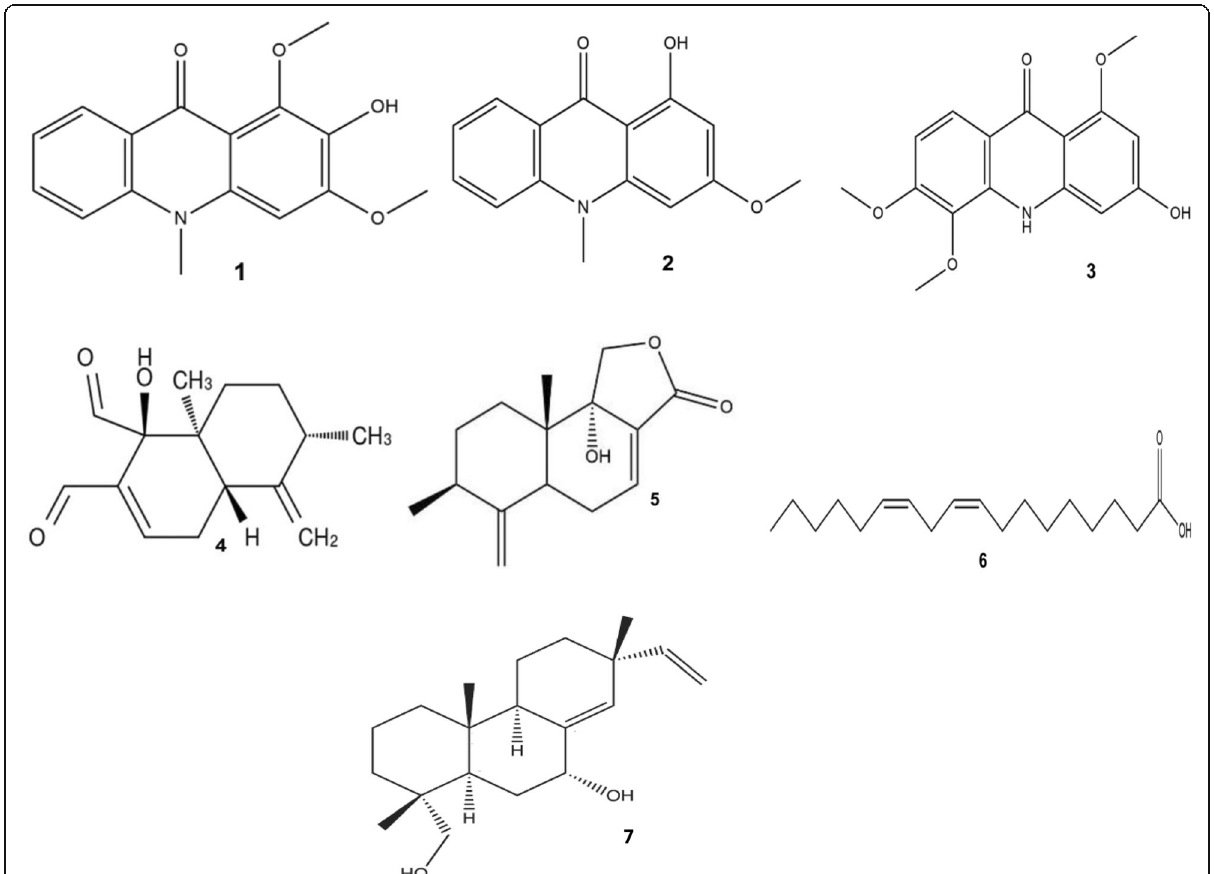
Fig. 5 Structure of antitubercular molecules isolated in claimed medicinal plants in East Africa. The numbers 1 – 7 correspond to the